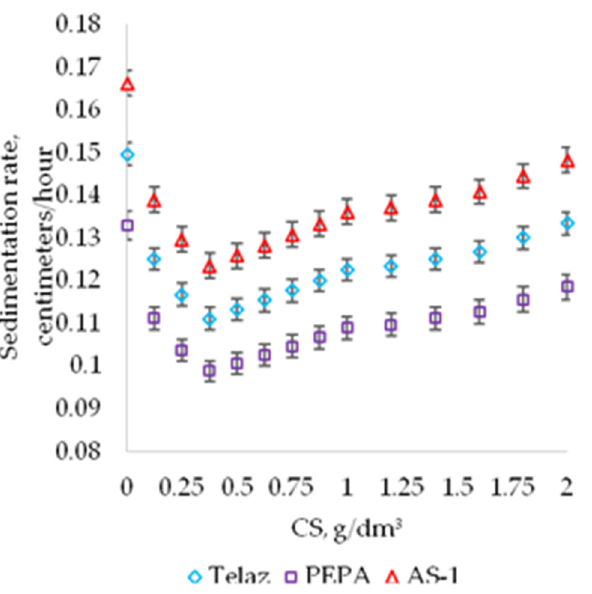
Figure 8. The effect of CS on the sedimentation rate of suspensions “aluminum pigment—PPhS— toluene” (centimeter/hour) at SC 10%.